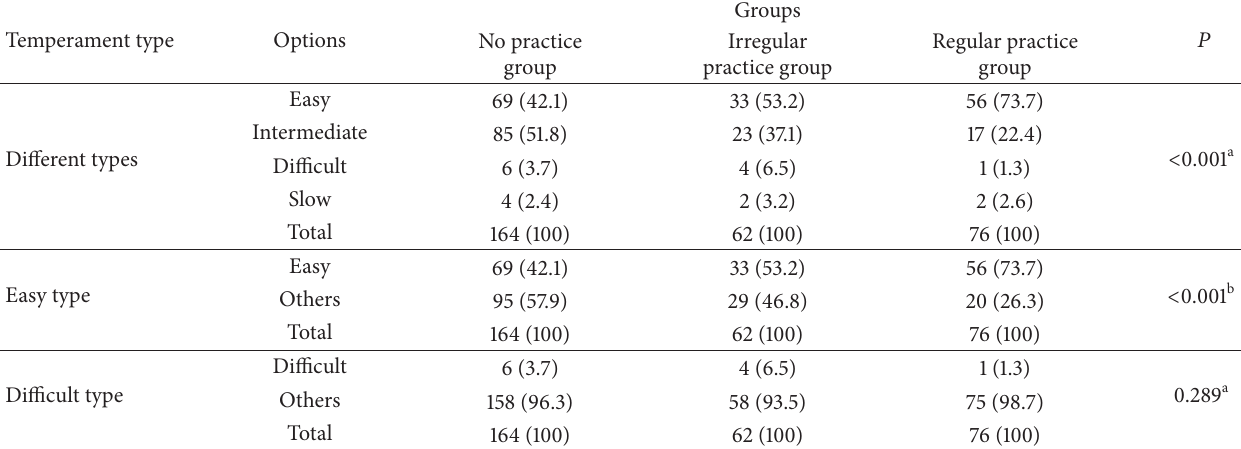
Table 3: Comparison of infant temperament type among the three groups 𝑁 (%).